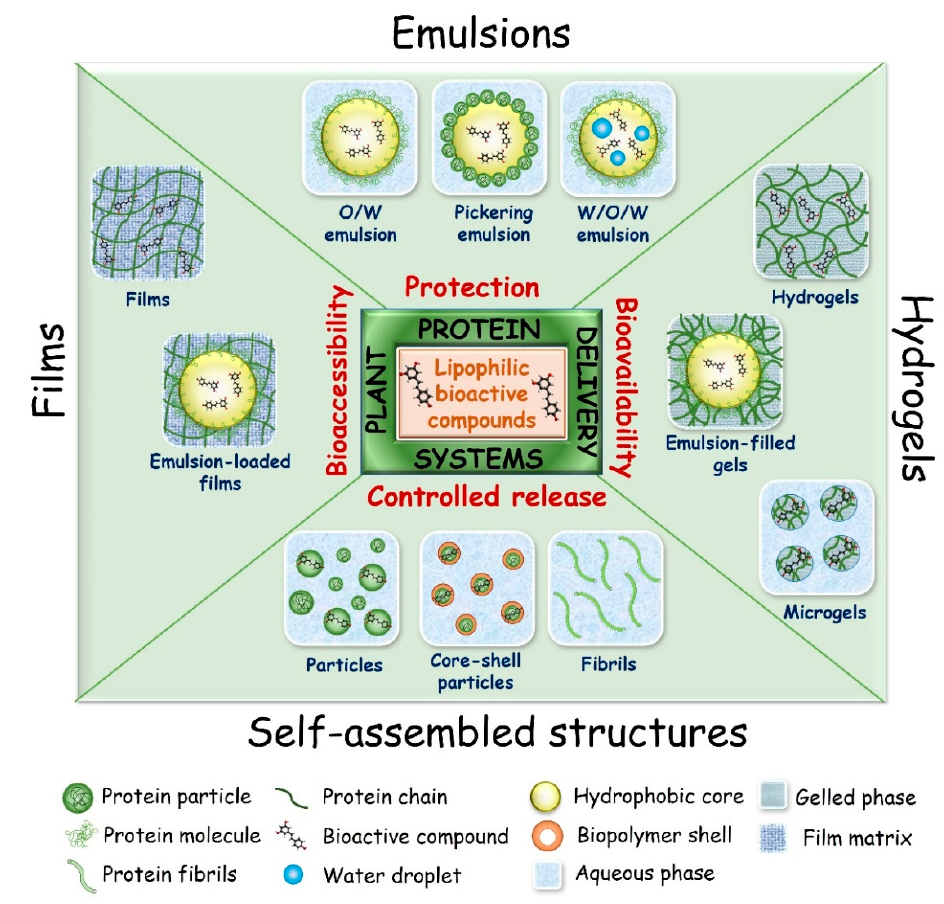
Figure 3. Overview of the different plant protein-based delivery platforms. Table 2. Recent studies on encapsulation of lipophilic bioactive compounds using plant-based proteins as carrier material.